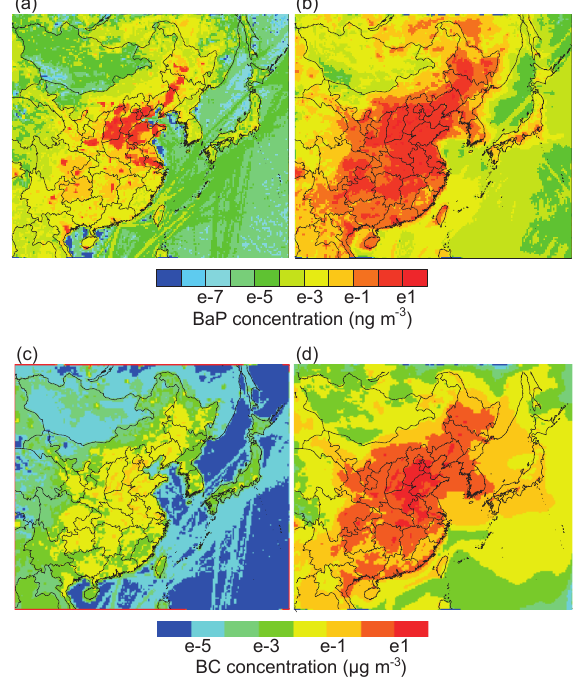
Figure 2. Simulated near-ground concentrations of BaP with (a) conventional transport scheme and (b) modified transport scheme for low-concentration species, and BC with (c) scaled low concentration and (d) normal concentration with conventional transport scheme averaged on 14 February